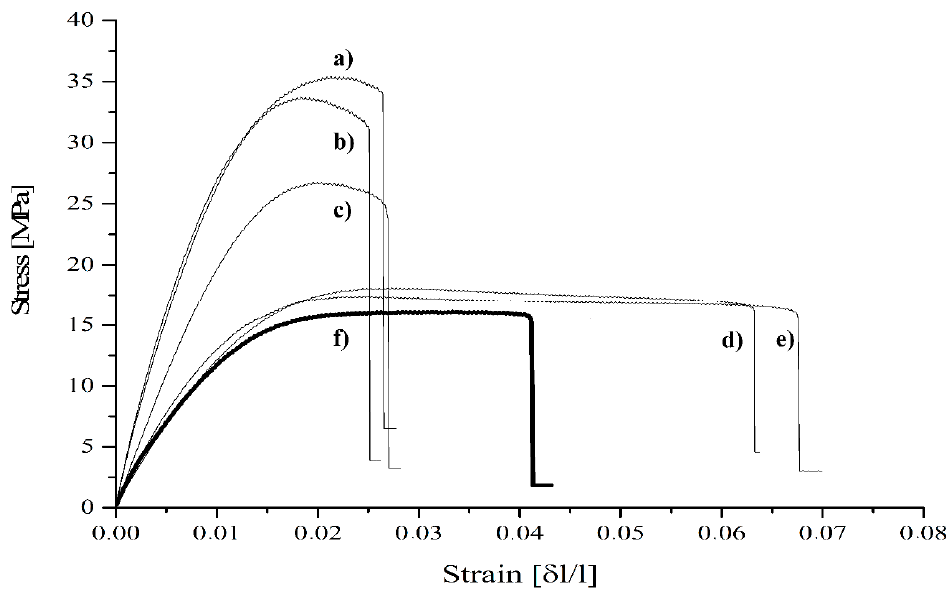
Figure 6. Stress versus strain curves of biochar-based composites filled with 2 wt.% of ( a ) WSP, ( b ) OSR, ( c ) RH, ( d ) SWP, ( e ) MSP, and of ( f ) neat resin.